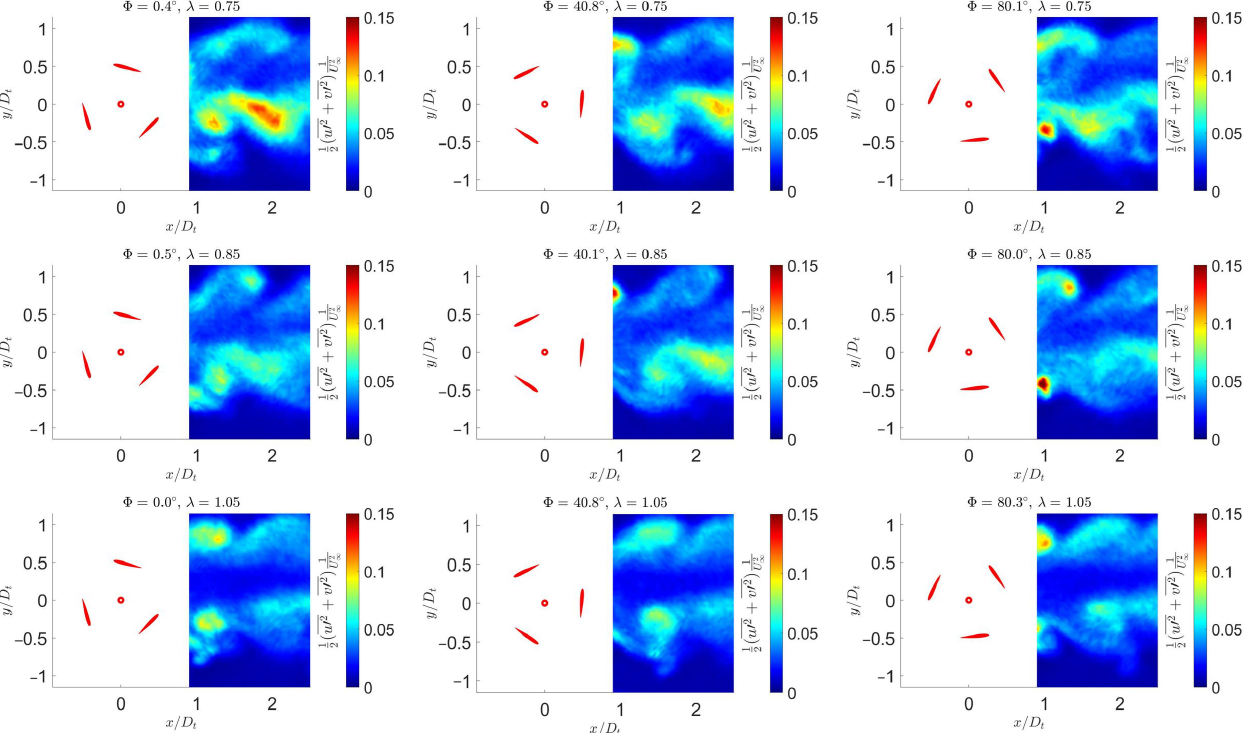
Figure 17. The random component of the phase-averaged kinetic energy of the flow behind turbine T1 at various phase angles and tip–speed ratios. The red circle displays turbine T1 rotation